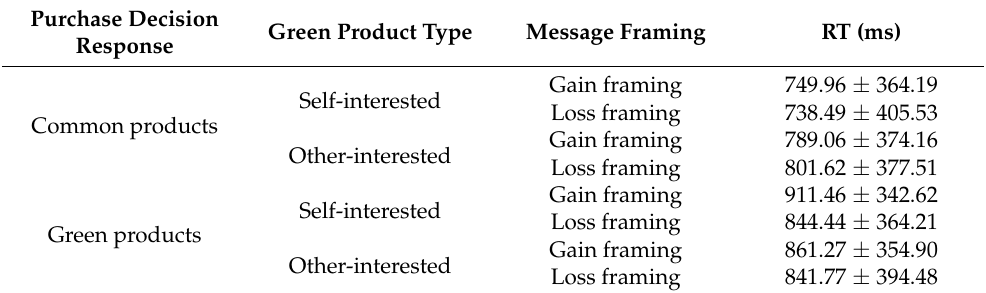
Table 4. Decision time in purchasing green products and common products under four conditions ( M ± SD ).